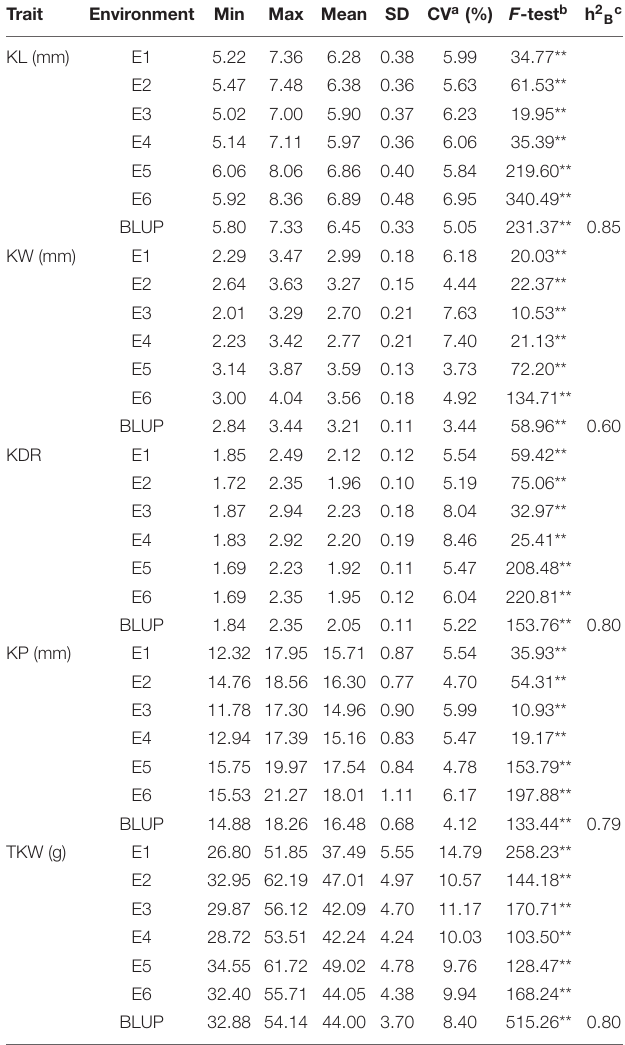
TABLE 1 | Descriptive statistics and heritability ( h 2 B ) of five kernel traits.